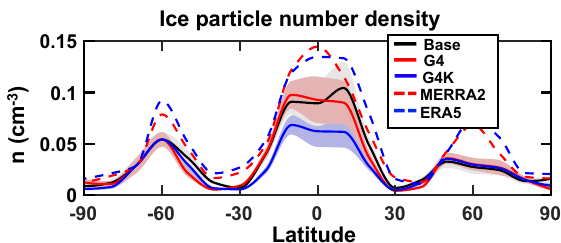
Figure 10. Globally and time-averaged number density values of ice crystals as a function of particle radius (d n/ dlog r , cm − 3 ) (years 2030–2069). Shaded areas of the same color represent ± 1 σ for the ensemble over the 40-year period from 2030 to 2069. The calculated global mean values of the ice particle effective radius are as follows: Base is 31 . 2 ± 3 . 2µm; G4 is 33 . 5 ± 3 . 6µm; and G4K is 36 . 8 ± 4 . 1µm. The reference MODIS value in Table 2 is 33 . 4 ± 2 . 1µm.